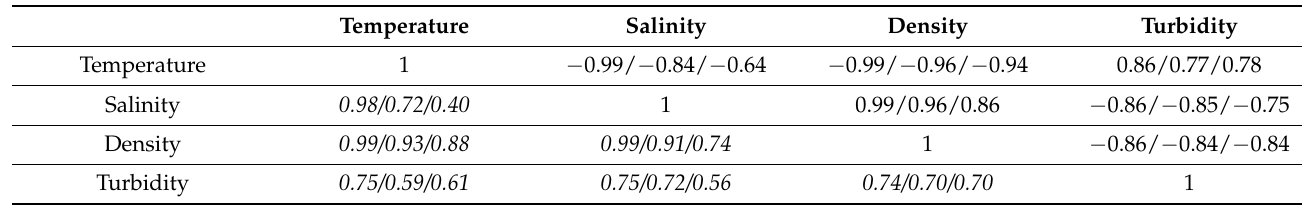
Table 3. Correlation coefficients and approximation confidence coefficients (in italics). Top layer/middle layer/bottom layer. Logachev